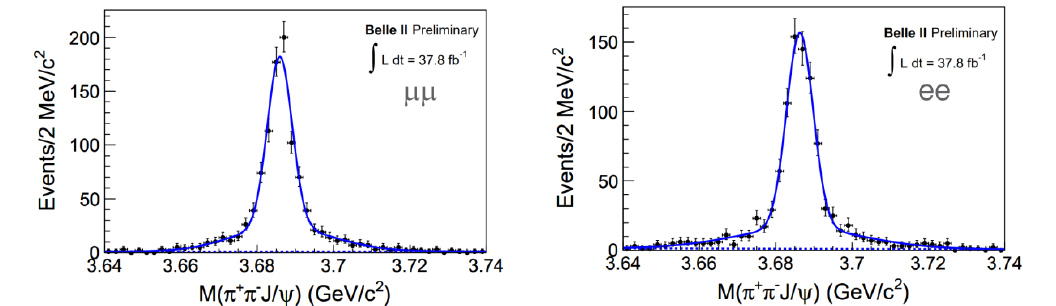
Figure 3: ψ ( 2 S ) state peaking in the J /ψπ + π − invariant mass distribution for the ISR process e + e − → π + π − J /ψ